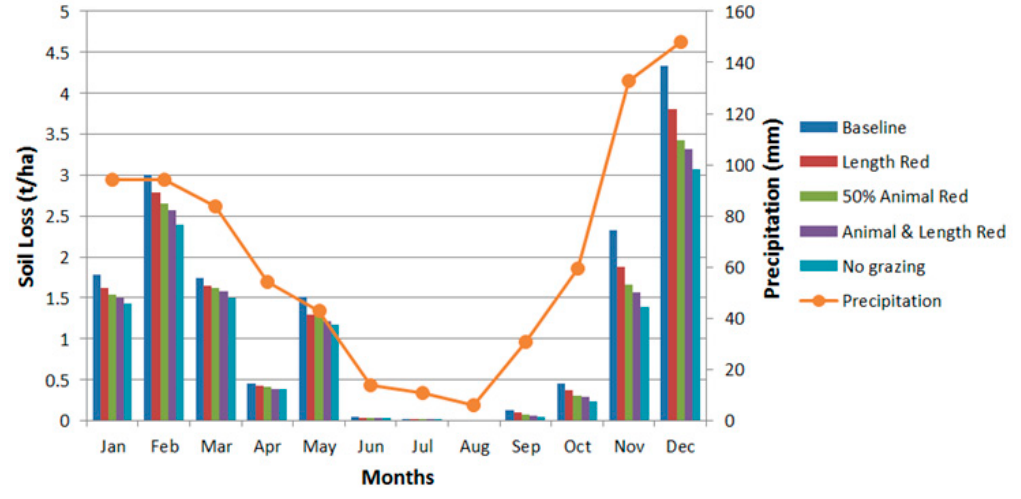
Figure 5. Temporal variation of soil loss in Samothraki.